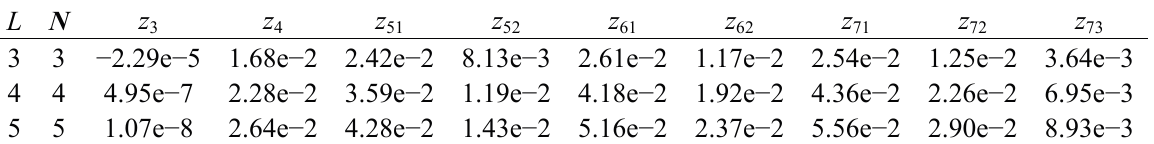
Table 12. Main attribution to maneuver error for LMSc algorithm.